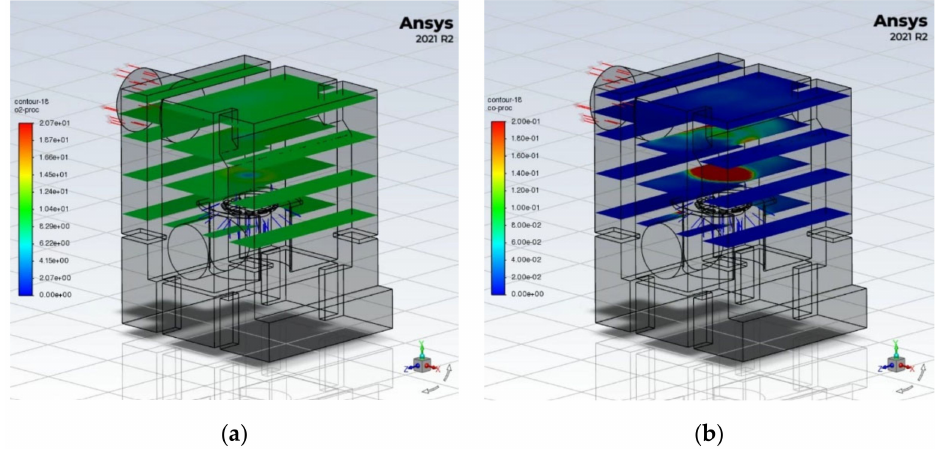
Figure 3. ( a ) O 2 concentration [%]; ( b ) CO concentration [%].